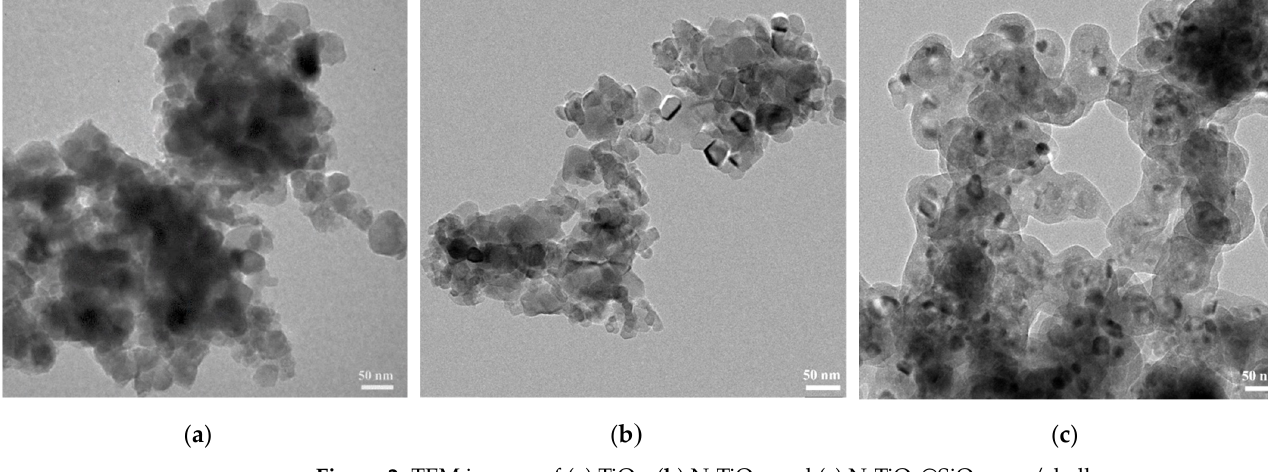
Figure 2. TEM images of ( a ) TiO 2 , ( b ) N-TiO 2 , and ( c ) N-TiO 2 @SiO 2 core / shell .